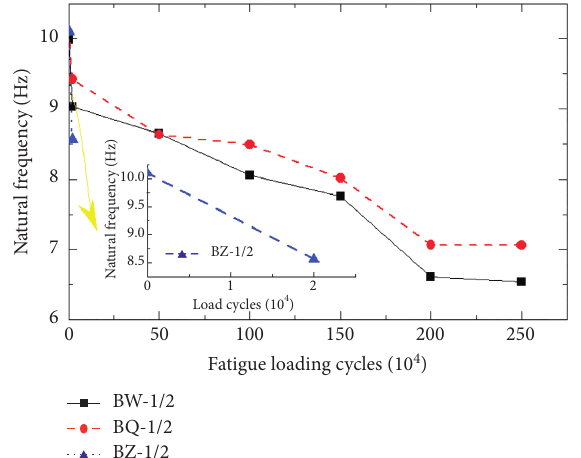
Figure 18: Natural frequency of test plate under fatigue loading.